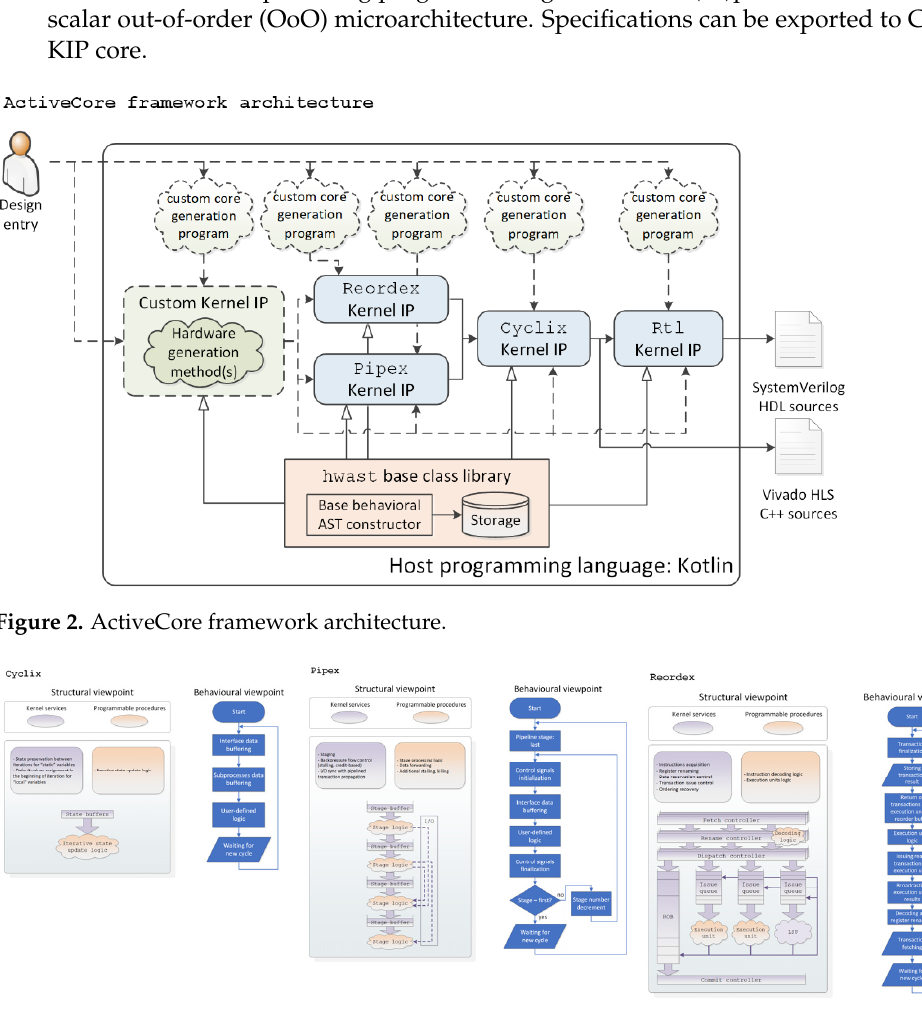
Figure 3. Overview of decoupled microarchitectural mechanisms and application logic in demo “Kernel IP cores”: Cyclix ( a ), Pipex ( b ), Reordex ( c ).